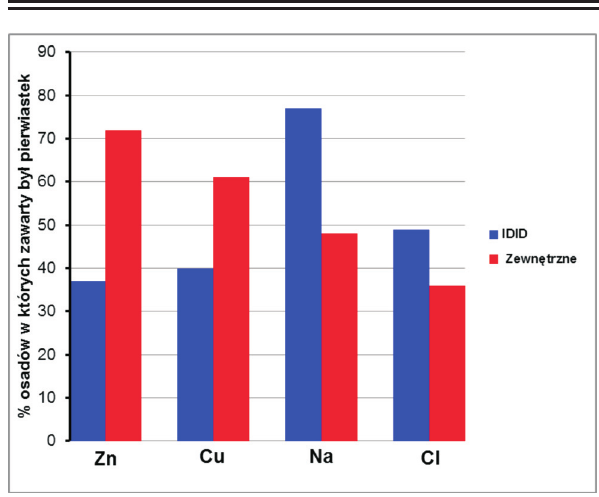
Fig. 6. Comparison of the impact of different metal ions on the forma - tion of external and internal injector deposits Rys. 6. Porównanie wpływu różnych pierwiastków metalicznych na tworzenie zewnętrznych i wewnętrznych osadów wtryskiwaczy